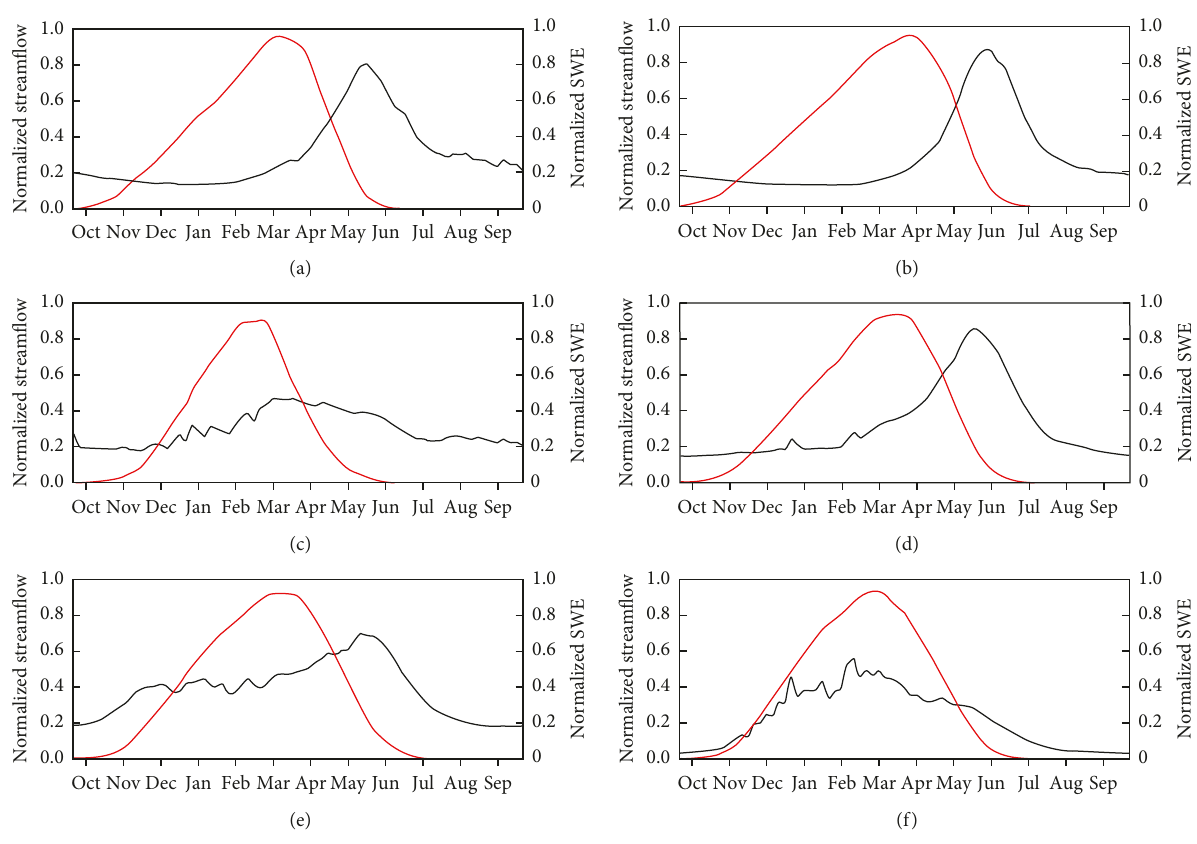
Figure 5: Annual time series (1981–2016) of the normalized SWE and streamflow (black line: streamflow; red line: SWE). Panels (a)–(f) successively represent watersheds (a) RG, (b) UC, (c) LC, (d) GB, (e) PNW, and (f)